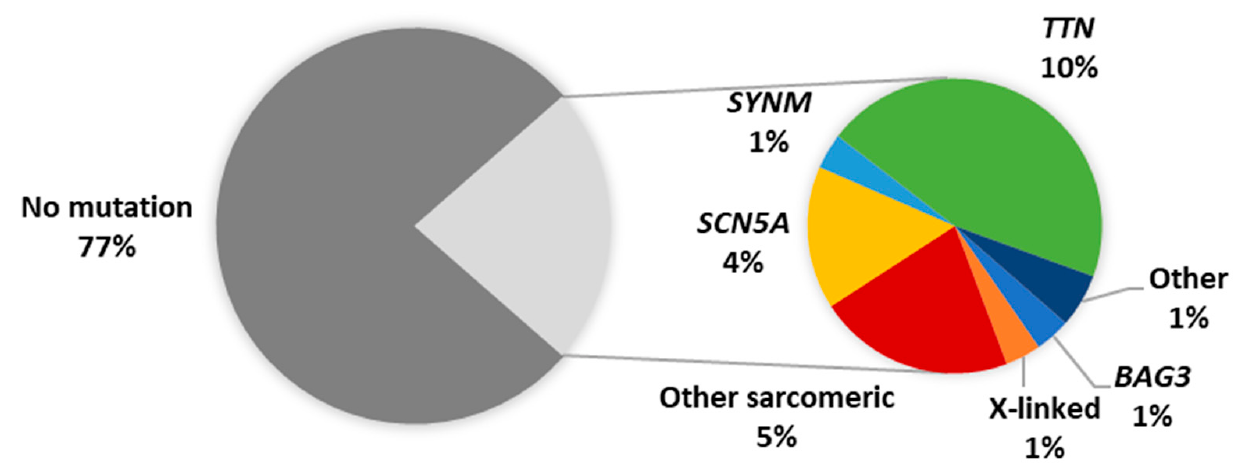
Figure 3. Proportion of reported PPCM patients with pathogenic mutations. Other sarcomeric genes: MYBPC3 , MYH6 , MYH7 , TNNC1 , TNNT2 , TPM1 ; X-linked genes: DMD , LAMP2 ; Other genes: DSP , PSEN2 , VCL .